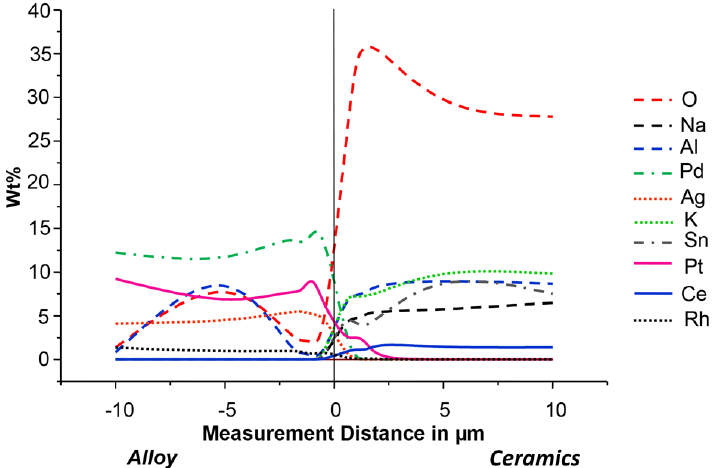
Figure 2. Concentration profiles of all elements near the metal-ceramic interface for the series P St, measured using EDX.